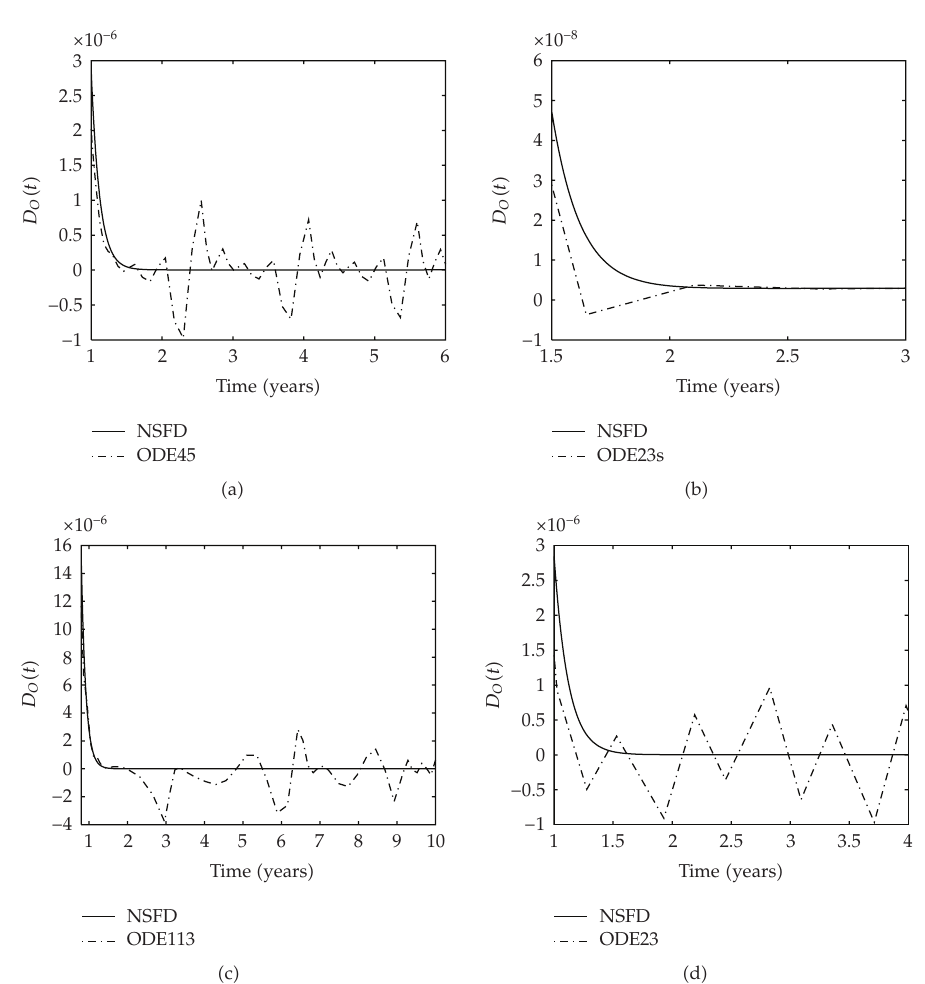
Figure 5: Solutions for subpopulation D O obtained by NSFD scheme and routines ODE45, ODE23s, ODE113, and ODE23 from MATLAB package (cid:3) dashed (cid:6) , using σ (cid:7) 0 . 0044379 × 10 − 5